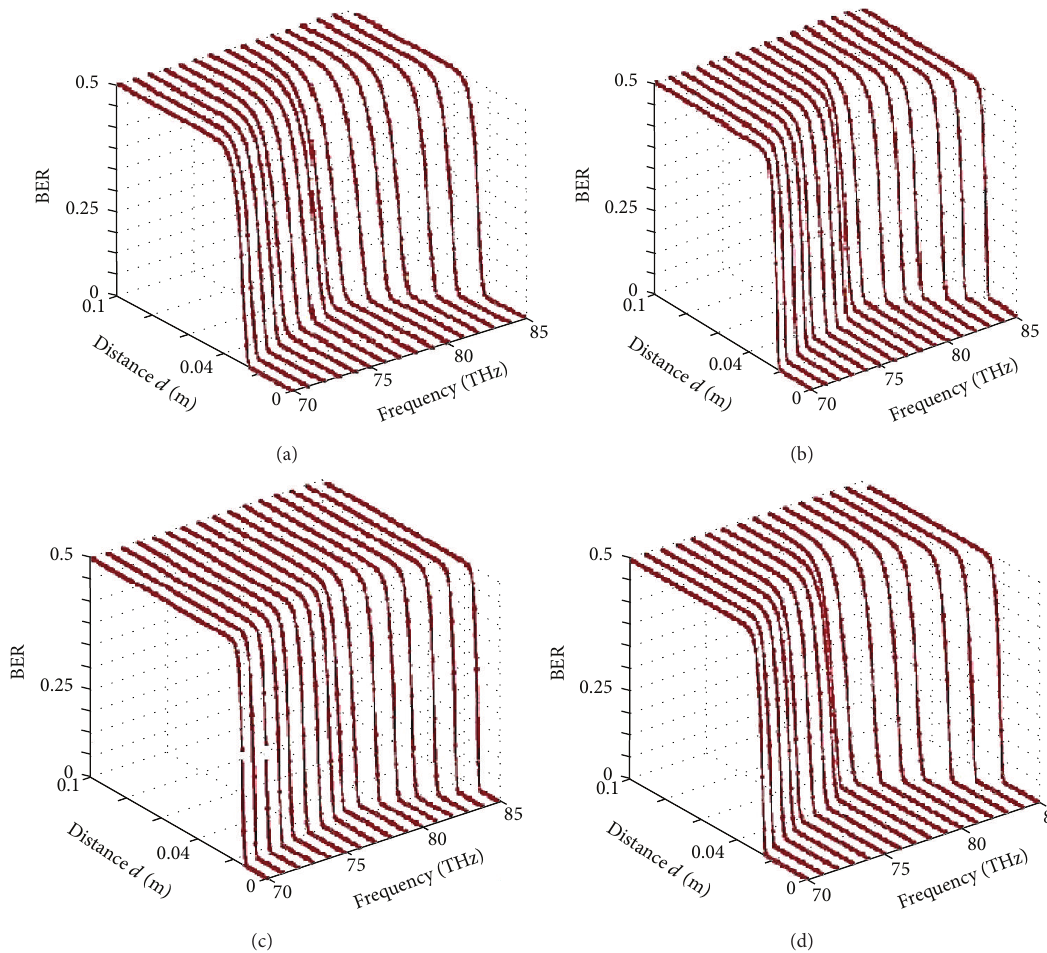
Figure 12: BER versus operating frequency and transmission distance for mixtures (a), (b), (c), and (d) with for 30dBm transmit